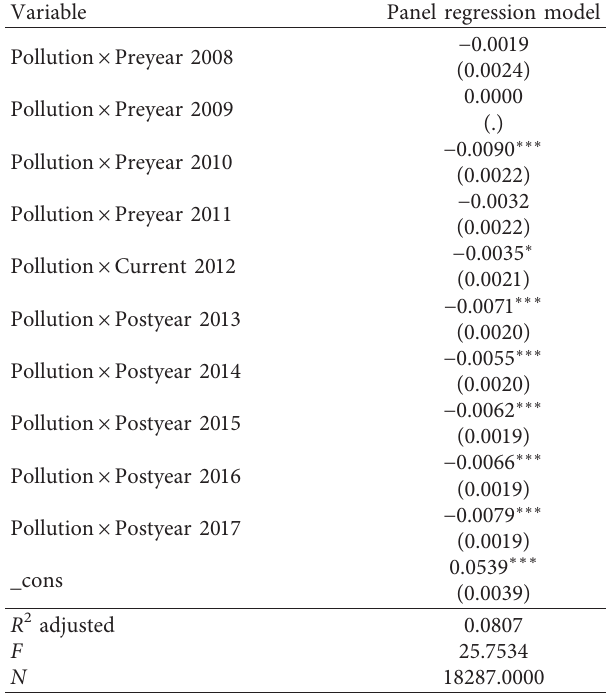
Table 5: Dynamic effect of green credit on investment efficiency. Variable Panel regression